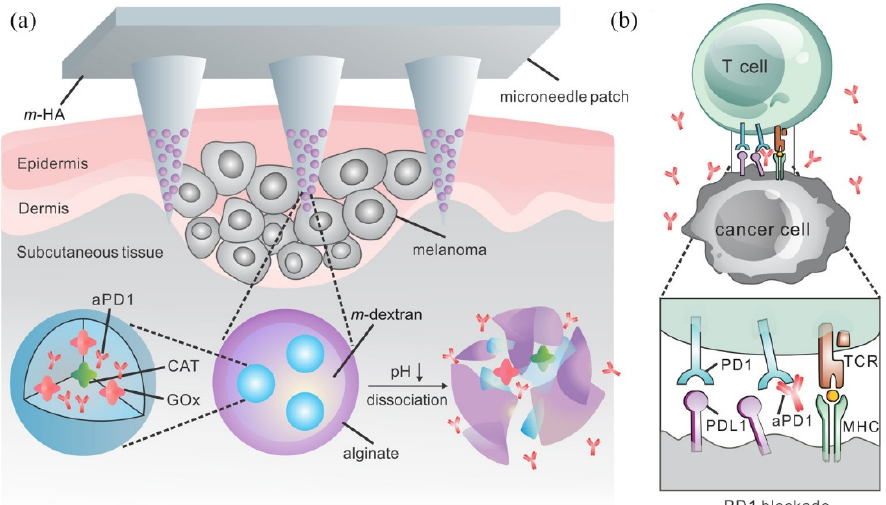
Figure 4. Schematic of the microneedle-assisted transdermal delivery of aPD1 for skin cancer treatment. ( a ) Schematic of the aPD1 delivered by an MN patch loaded with physiologically self-dissociated NPs. With GOx/CAT enzymatic system immobilized inside the NPs by double-emulsion method, the enzyme-mediated conversion of blood glucose to gluconic acid promotes the sustained dissociation of NPs, subsequently leading to the release of aPD1. ( b ) The blockade of PD-1 by aPD1 activates the immune system to destroy skin cancer cells. Reproduced from [92] .